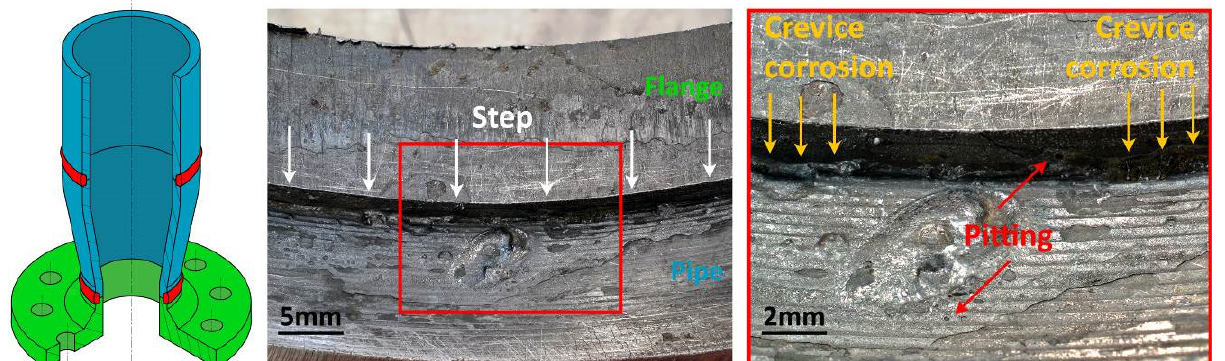
Figure 3. Joints’ inner surfaces after cleaning. Pictures show the step between the welded edges; pitting and crevice corrosion are highlighted with red and orange arrows, respectively.